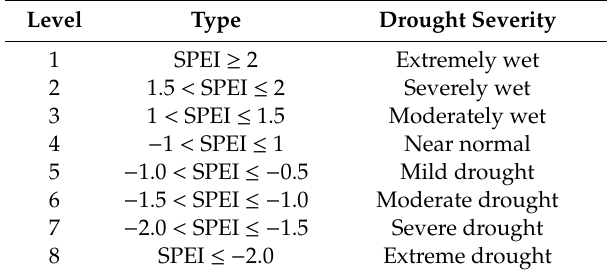
Table 1. Categorization of meteorological drought through the SPEI.